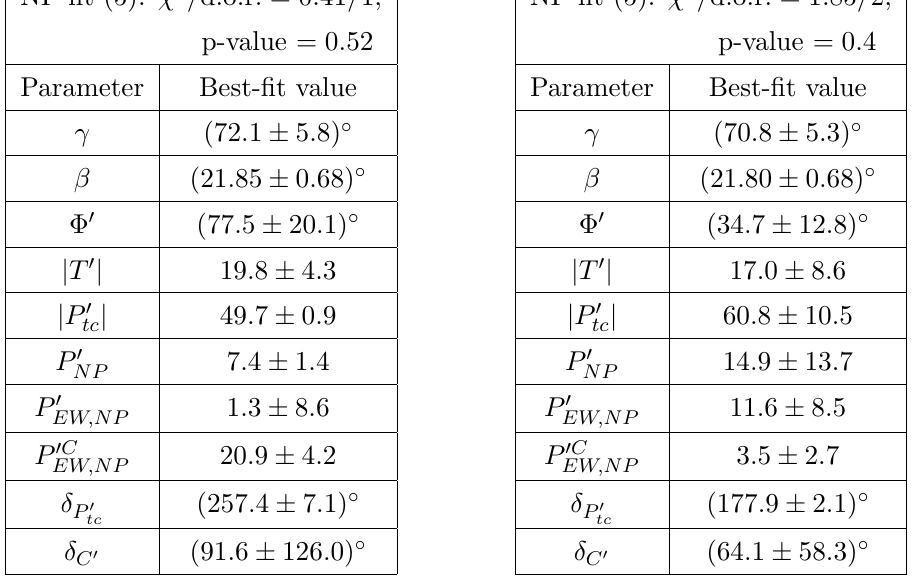
Table 7 . (cid:31) 2 = d : o : f : and best-(cid:12)t values of unknown parameters for the Z 0 model where all three NP min operators are present in B ! (cid:25)K . Left-hand table has constraints: B ! (cid:25)K data, measurements of (cid:12) and (cid:13) , j C 0 =T 0 j = 0 : 2. Right-hand table has constraints: B ! (cid:25)K data, measurements of (cid:12) and (cid:13) , j C 0 =T 0 j = 0 : 2, and j P 0 C =P 0 j = 0 : 3. EW;NP EW;NP